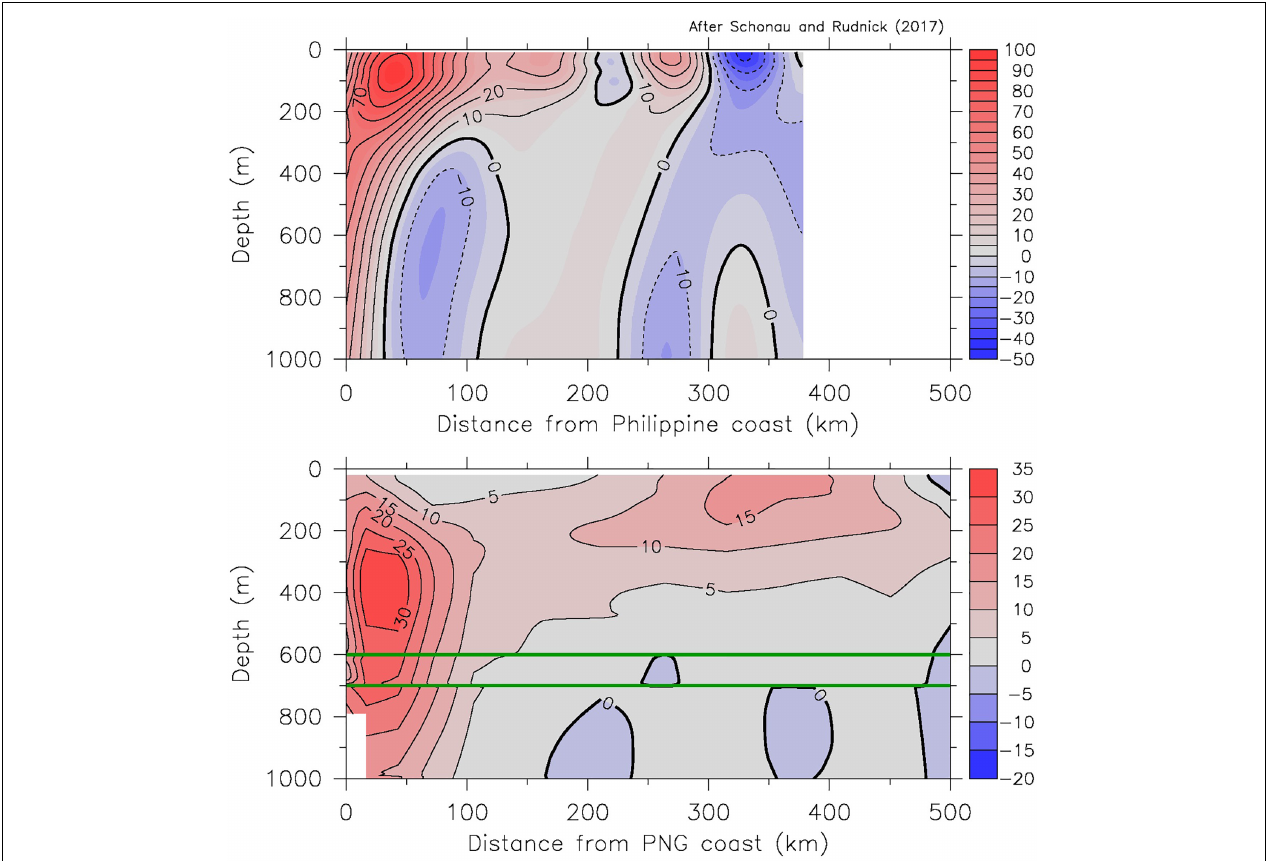
FIGURE 6 | Mean absolute geostrophic velocity on two transects across the LLWBCs of the Northern (top) and Southern (bottom) Hemispheres, from glider data. Red (positive) is equatorward in both panels, but the contour levels are different (scales in cm/s at right of each panel). The (top) panel is redrawn from Figure 4 of Schonau and Rudnick (2017). The green lines in the bottom panel separate regions with different sampling periods and were contoured separately. The western boundary currents are the red areas tight to the western edge, in each case about 100 km wide; note that the northern LLWBC (Mindanao Current) is surface-intensified with its maximum above 100 m, while the southern LLWBC has its core near 400 m, and little surface expression.